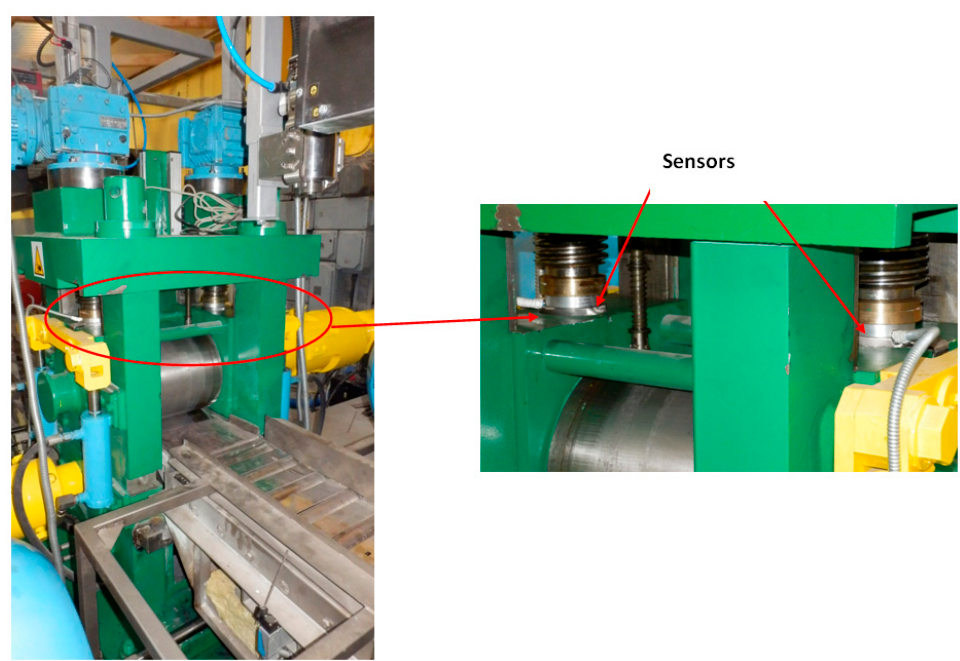
Figure 4. View of the laboratory rolling mill at mill DUO 300.